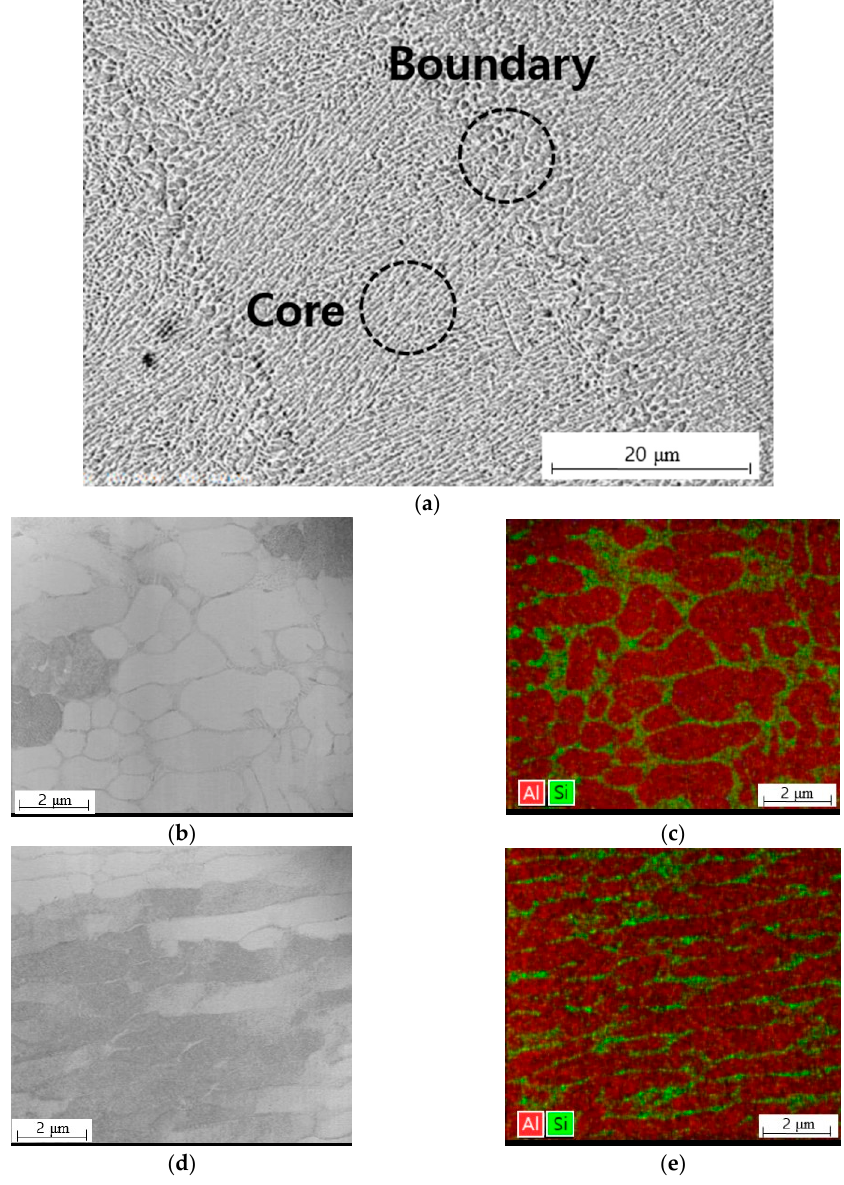
Figure 10. ( a ) SEM representative image of melt pool; ( b ) morphology of microstructure by TEM and ( c ) EDX composition map at boundary of melt pool; ( d ) morphology of microstructure by TEM; and, ( e ) EDX composition map at core of melt